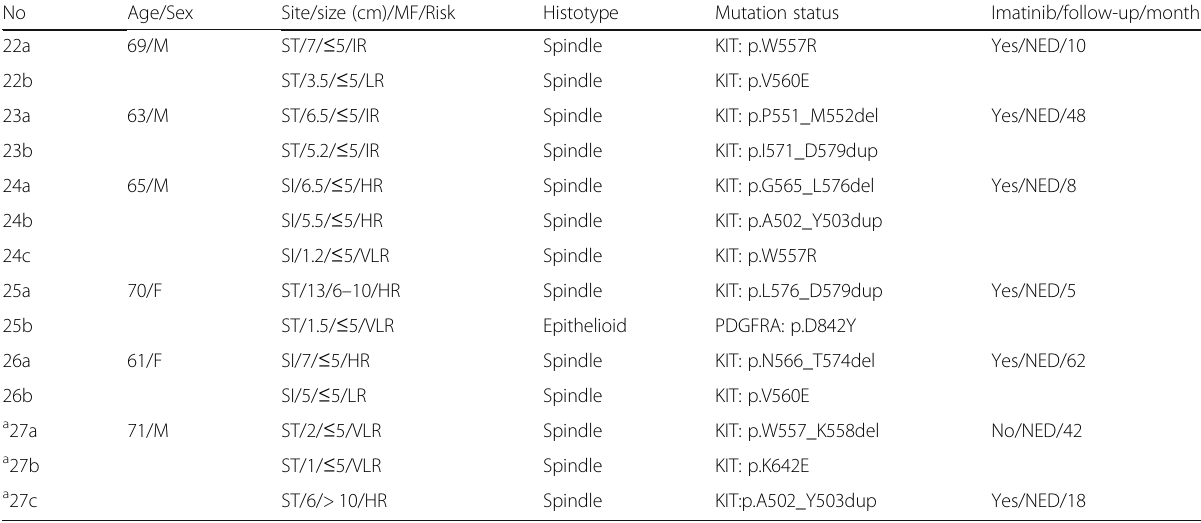
Table 1 Clinicopathologic and molecular features of 27 patients with multiple sporadic GISTs (Continued)